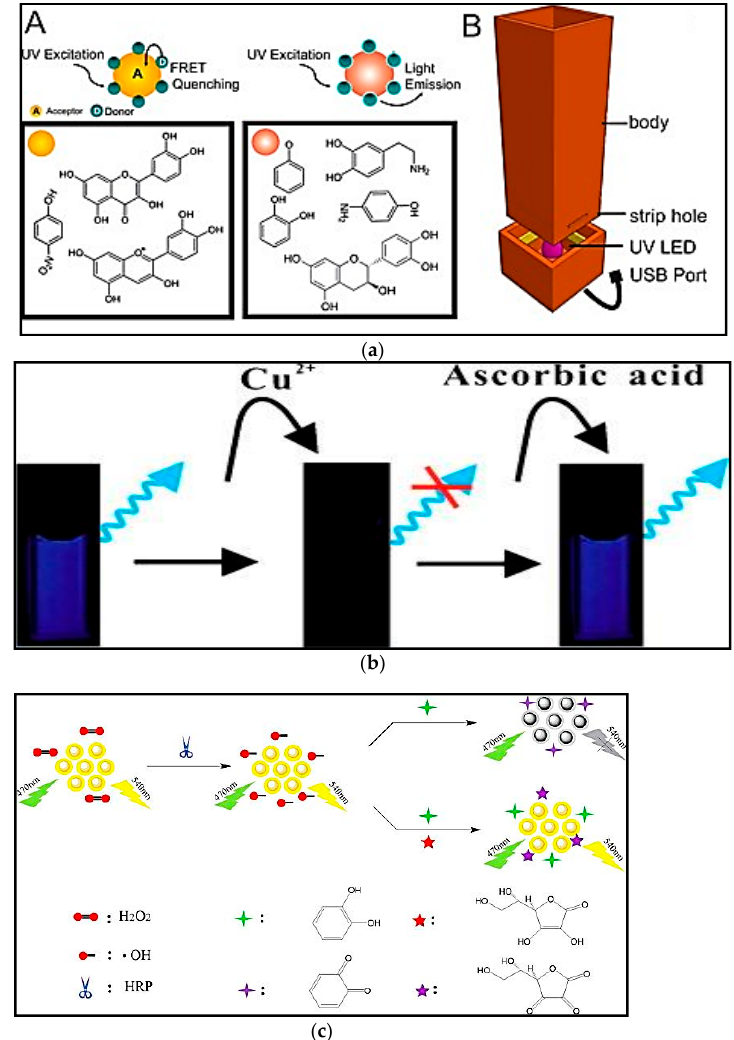
Figure 3. ( a ) Illustrative representation of the fluorescence quenching of Quantum Dots in the existence of an analyte by the FRET phenomenon. ( A ) Phenolic mixtures susceptible of producing GQDs quenching and those can’t produce it are denoted with a yellow and red circle, respectively. ( B ) 3D-printed apparatus with its different segments; ( b ) Schematic drawing of the sensing procedure for AA based on GQD-Cu 2+ probe; ( c ) Schematic illustration of the process for Ascorbic acid recognition. Reprinted with permission from [71,72,74], respectively.